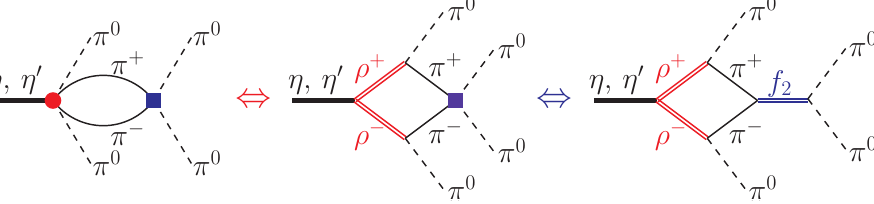
Fig. 3. Feynman diagrams contributing to η ′ ,η → 4 π 0 at O ( p 10 ). Left: Pion-loop contribution; the left vertex (red circle) denotes the e ff ective η,η ′ → π + π − 2 π 0 coupling of O ( p 6 ) (see Sect. 2), the right vertex (blue square) an e ff ective D-wave ππ rescattering of O ( p 4 ). Middle: Saturation of the O ( p 6 ) process by vector ( ρ ± ) meson dominance (red). Right: D-wave π + π − → π 0 π 0 scattering saturated by f 2 (1270) tensor meson dominance